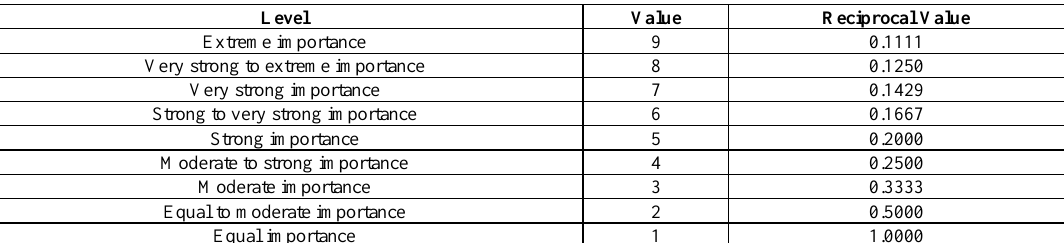
Table 4. The scale of the criteria set